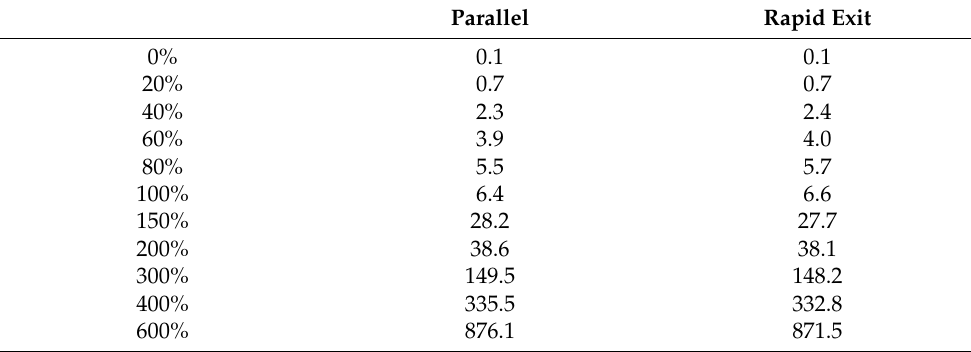
Table 12. Annual savings compared to U-turn (Million